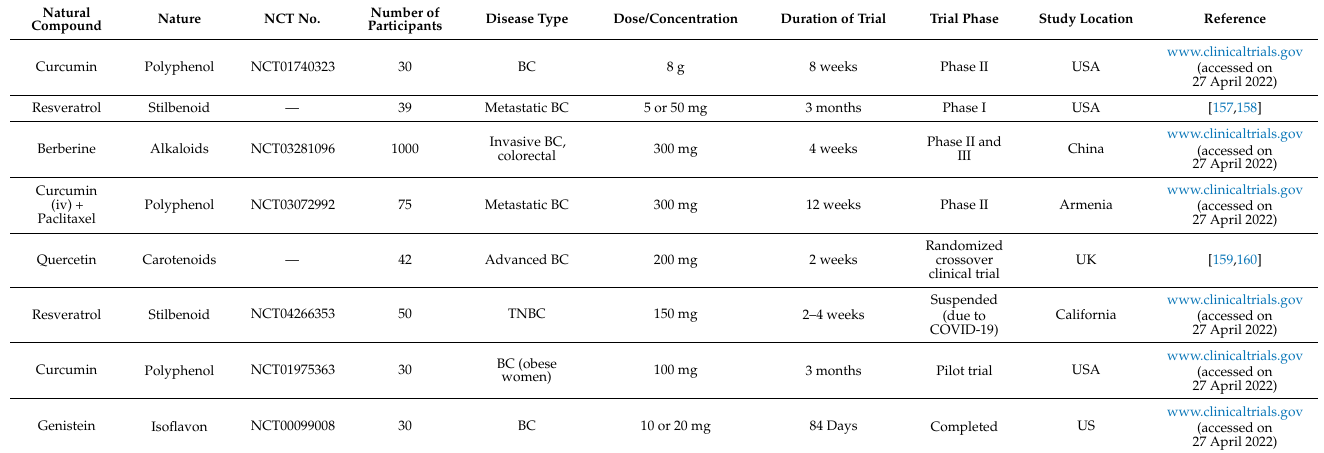
Table 2. The representation of clinical trial studies of some natural compounds against BC.